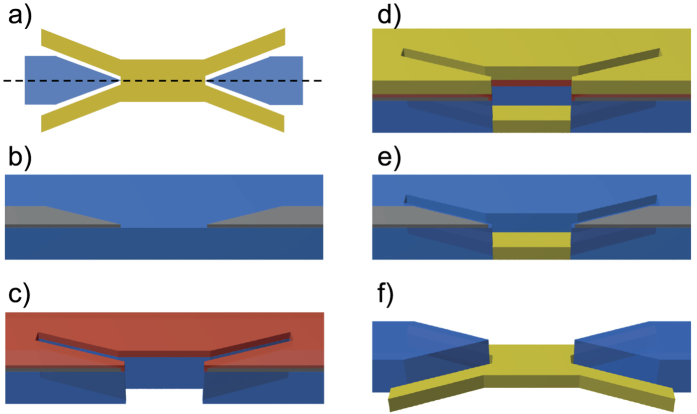
Simplified overview of the different steps during processing of the photonic-plasmonic on-chip structures.(b–e) Cut along the dashed line in (a). (b) Ni mask (grey) for the dielectric waveguides in Si3N4 (blue), (c) ZEP resist (red)/Si3N4 mask for the plasmonic components after the second etching step, (d) gold evaporation (yellow layer comprises Cu, Au and Ni layers), (e) lift-off of gold on ZEP resist, (f) final etching step (and removal of remaining protective Ni on gold and dielectric structures).